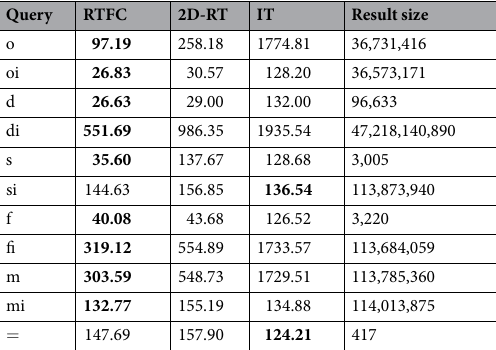
Table 6. The query time of the 11 intersection queries (in seconds) and the corresponding result set sizes with gnomAD intervals as query intervals and ENCODE intervals as data intervals. Abbreviations: RTFC = range tree with fractional cascading; 2D-RT = basic 2-dimensional range tree; IT = interval tree.